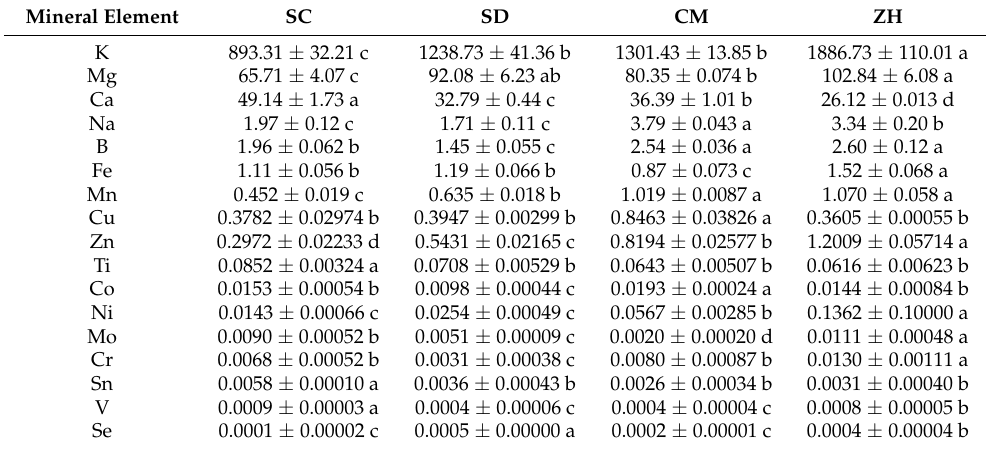
Table 2. The mineral element of Cuiguan pear with four different regions (mg/kg). Mineral